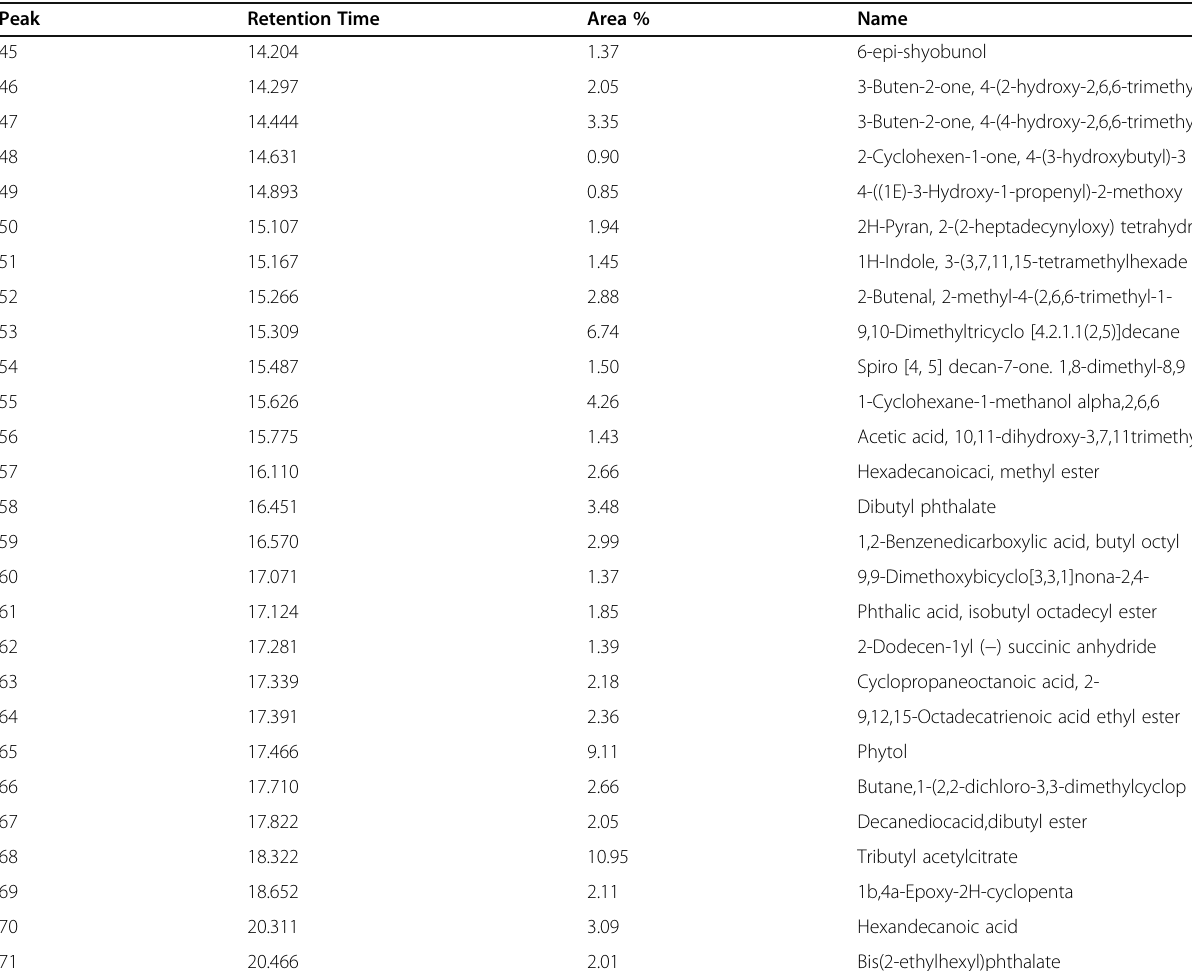
Table 7 Chemical composition of the n-butanol fraction of P. guineense following GC-MS analysis (Continued)